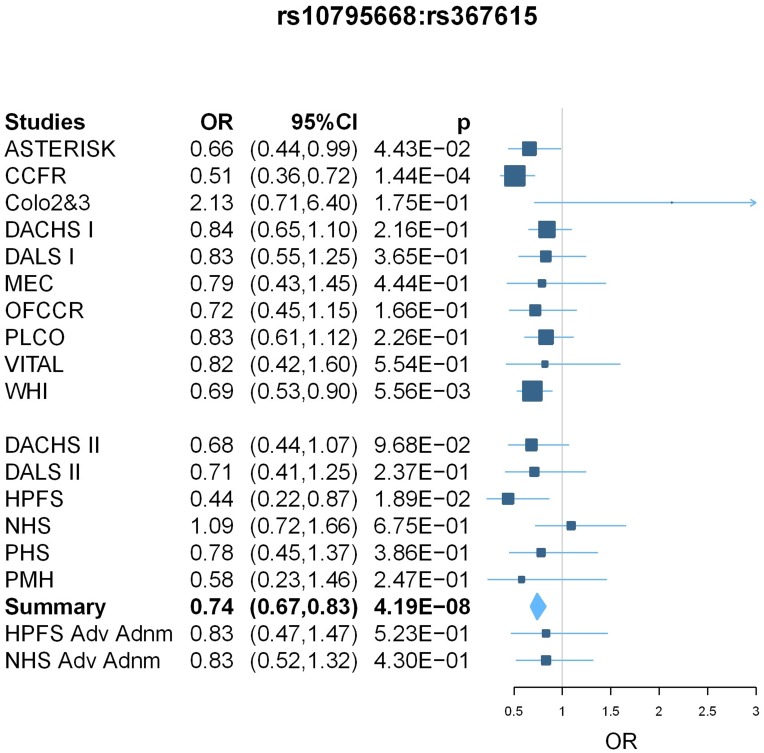
Forest plot for meta-analysis results of GxG between rs10795668 and rs367615.Box sizes are proportional to the inverse variance for each study and the lines depict the confidence intervals. The diamonds represent the fixed effects meta-analysis results, with the width of the diamond representing the confidence interval. The results of two advanced adenoma studies (HPFS Adv Adnm and NHS Adv Adnm) are shown at the bottom but not incorporated in the meta-analysis.